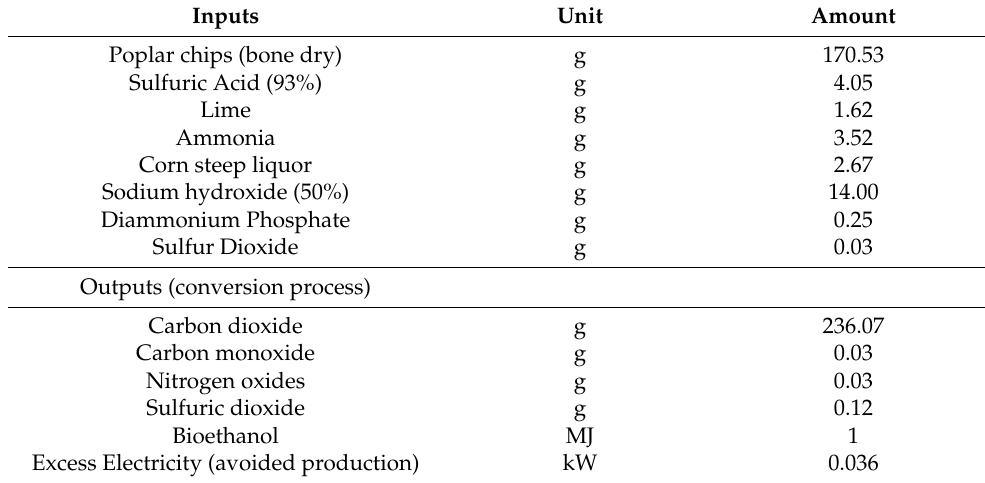
Table 2. LCI of the bioconversion of the biomass process stage to produce 1 MJ of bioethanol. Inputs Unit Amount Poplar chips (bone dry) g